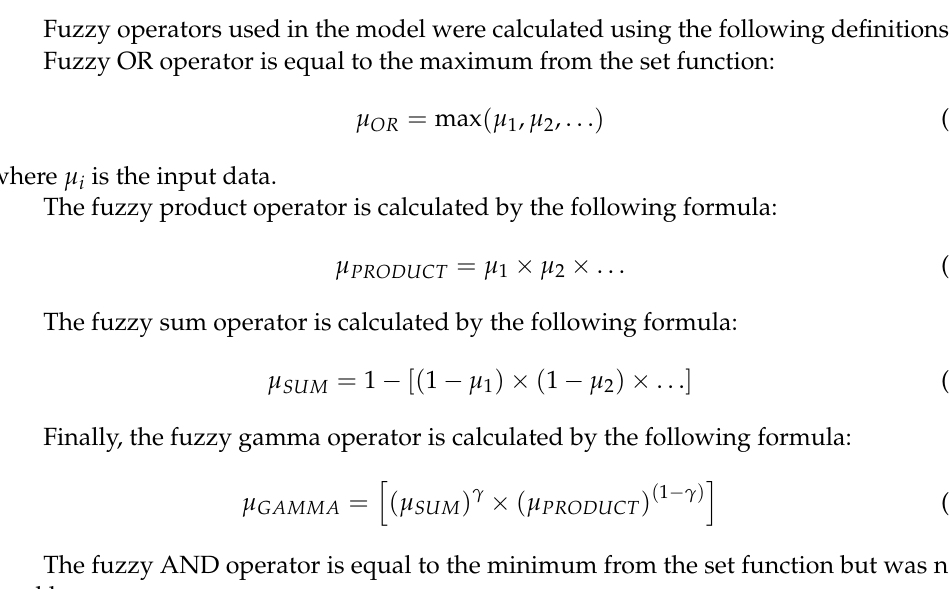
Figure 8. Fuzzy logic model for Scenario